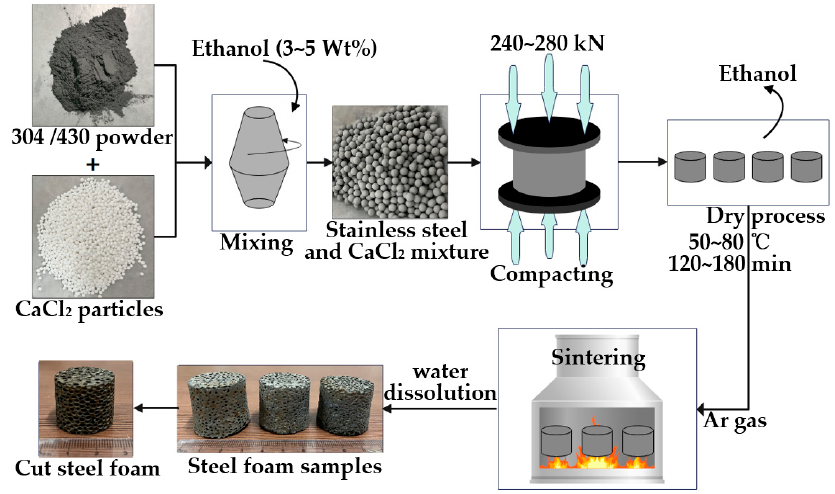
Figure 1. The schematic diagram of preparation process for SSF samples.